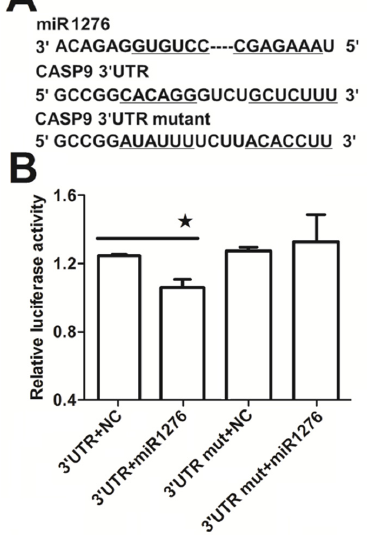
Figure 5. MiR1276 ‐ speci fi c binding to the 3 ʹ UTR of CASP9 . (A) Binding site in 3 ʹ UTR of the CASP9 mRNA predicted by the TargetScan online program. (B) Relative luciferase activity analyzed by the dual ‐ luciferase reporter assay in HeLa cells. The psiCHECK2 ‐ CASP9 3 ʹ UTR (3 ʹ UTR) or psiCHECK2 ‐ CASP9 3 ʹ UTR mutant (3 ʹ UTR mut) was co ‐ transfected into HeLa cells with miR1276 expression plasmid (miR1276) or its negative control plasmid (NC). Results are presented as means ± SEM from three independent experiments with at least three replicates in each test. 3 (cid:48) UTR + NC vs. 3 (cid:48) UTR + miR1276 were analyzed with the Student’s t-test. * p < 0.05.